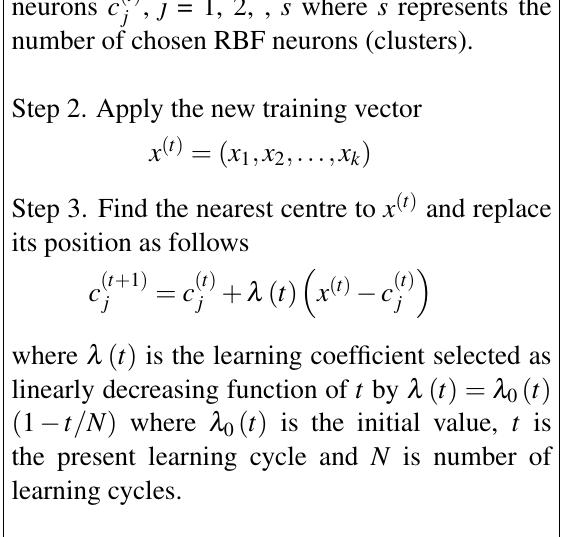
Fig. 5. RBF neural network